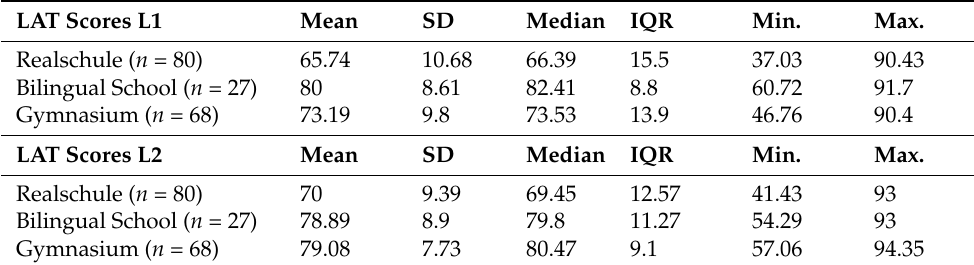
Table 6. LAT scores in L1 and L2 across school types.